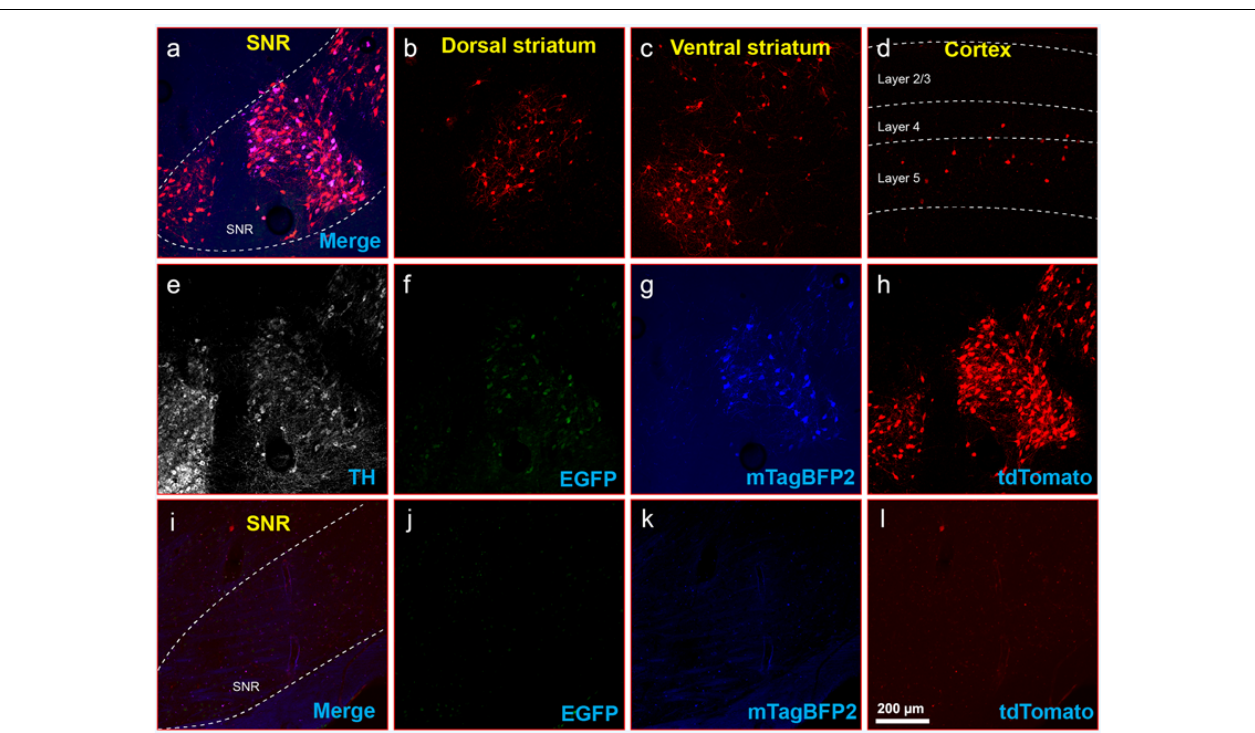
FIGURE 8 | Inputs to midbrain dopaminergic cells using recommended dilutions of two-helper combination. (A–H) Results in DAT-Cre mice. (A) Injection site in substantial nigra reticulata (SNR): overlay of panels (F–H) . (B) RV-labeled cells in the dorsal striatum. (C) RV-labeled cells in ventral striatum. (D) RV-labeled cells in the cortex. (E) Anti-tyrosine hydroxylase (TH) staining (not shown in panel A ). (F) Anti-EGFP staining, indicating expression from the first, Cre-dependent AAV. (G) mTagBFP2, indicating expression from the second, tTA-dependent AAV. (H) tdTomato, reporting activity of the FLPo-encoding RV. (I–L) Results in Cre-negative mice (injection site shown). (I) Overlay of (J–L) . (J) anti-EGFP staining: no signal is visible, even with immunostaining. (K) mTagBFP2 signal. no signal is visible, even with amplification. (L) tdTomato, reporting activity of the FLPo-encoding RV. Only one labeled cell is visible. Scale bar in (A) : 200 µ m, applies to all panels.